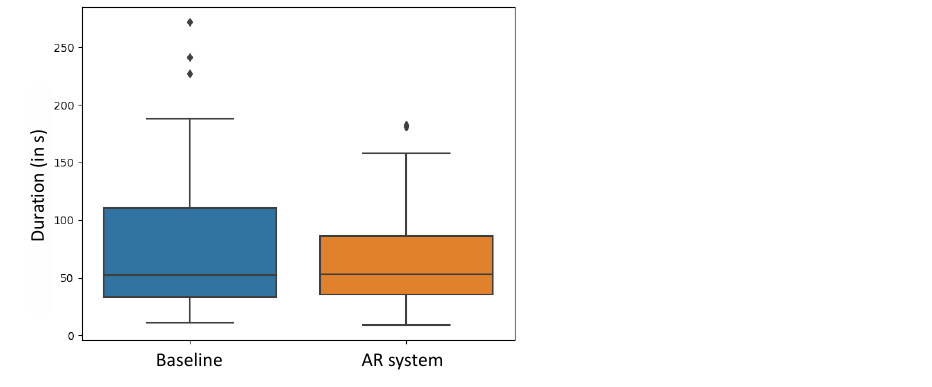
Figure 8. The duration of the alignment task per trial, comparing baseline and AR-guided positioning.